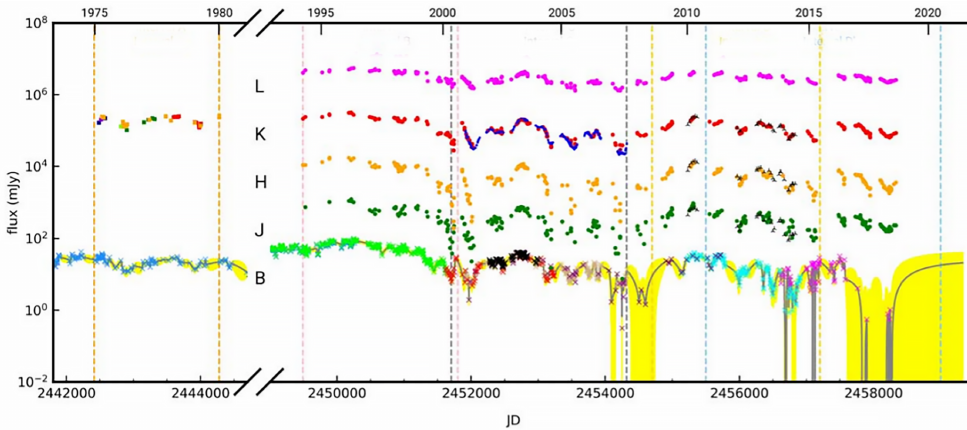
Figure 14. Historical light curves of NGC 4151 compiled from Lyu & Rieke [11]. For details on the data sources and the adjustment of the data to make all the sources consistent, see their